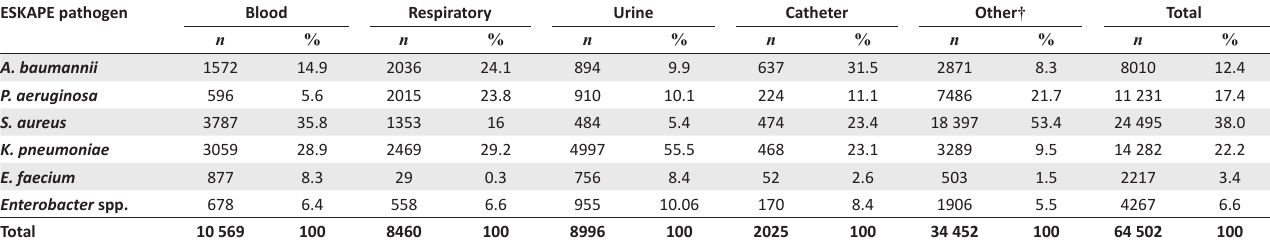
TABLE 3: Distribution of ESKAPE pathogens isolated from clinical samples collected in public sector healthcare facilities in KwaZulu-Natal from 2011–2015. ESKAPE pathogen